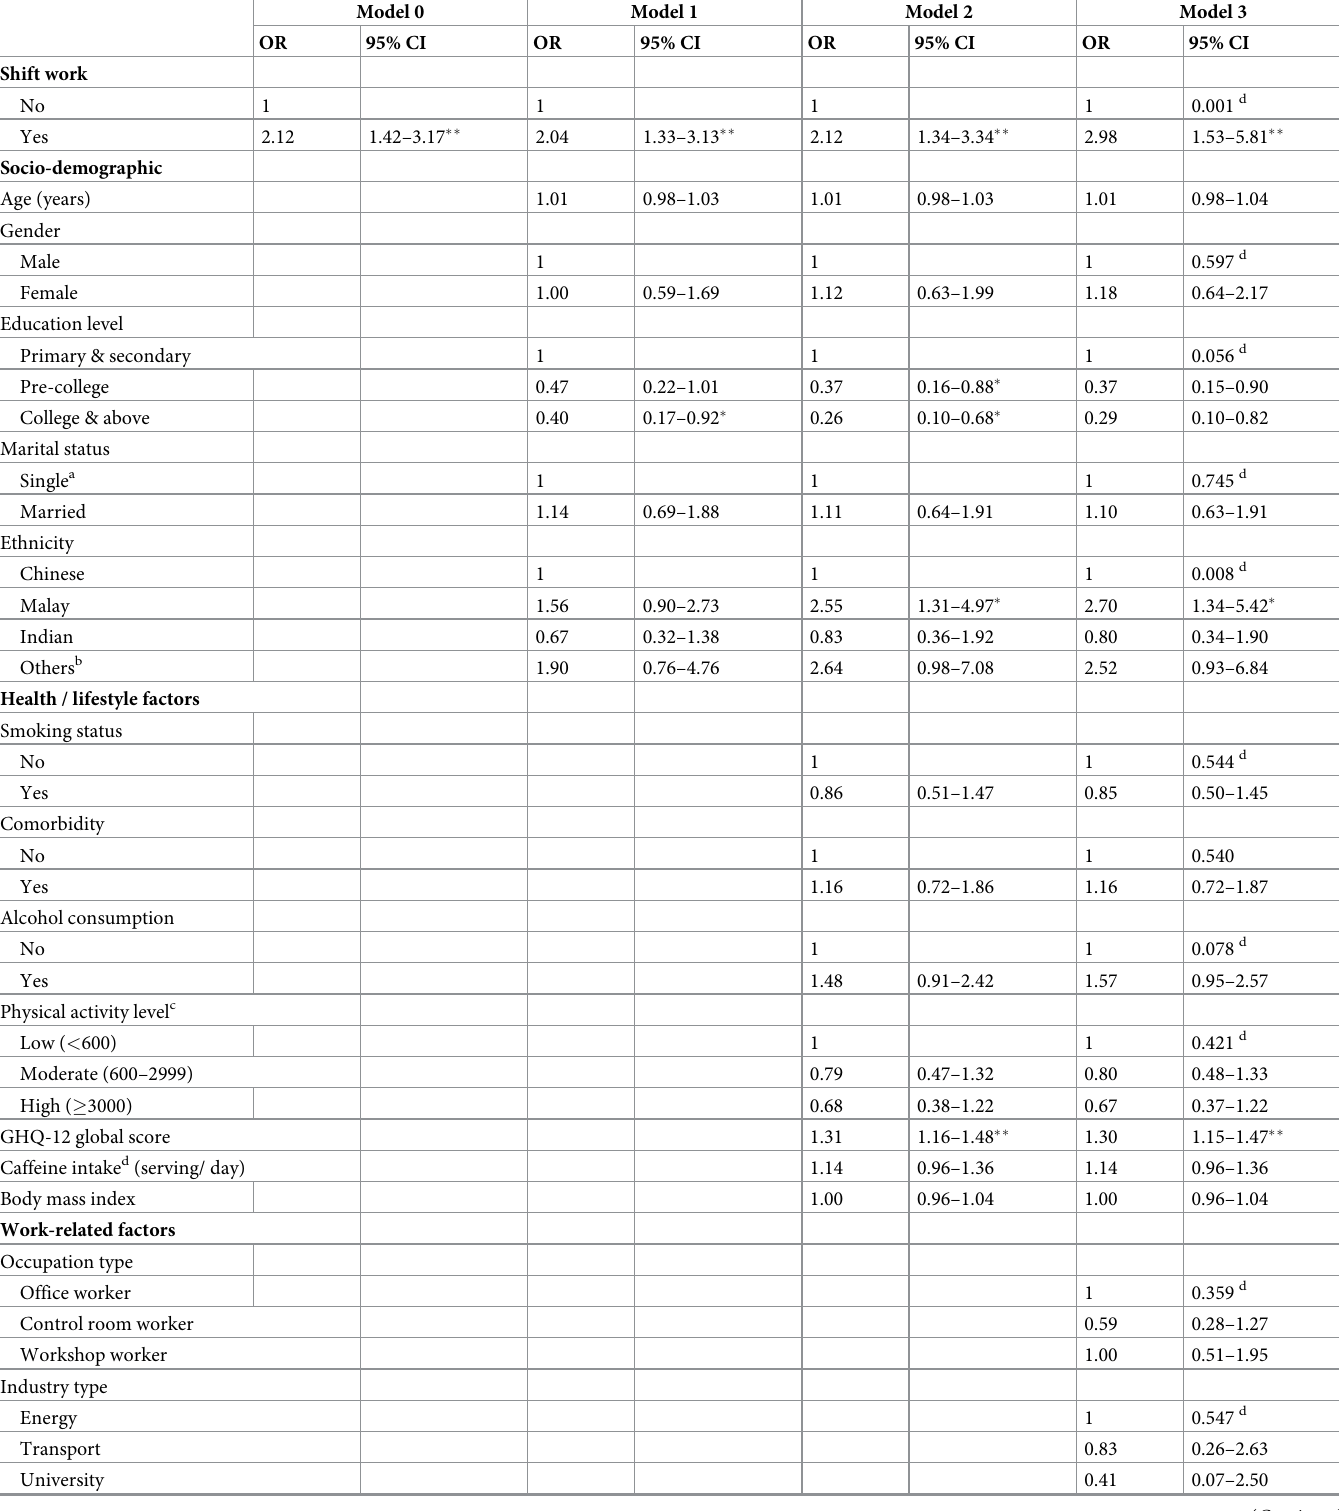
Table 4. Odds ratios (OR) and 95% confidence intervals (CI) for poor sleep associated with shift